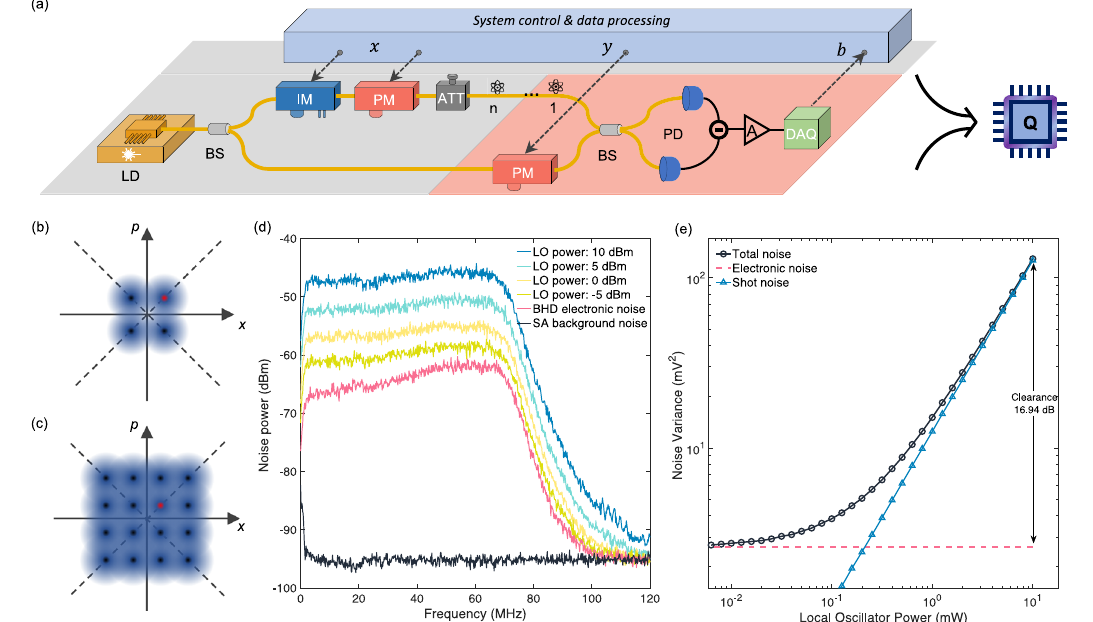
Fig. 1 | Experiment Overview. a Schematic of the experimental setup. The Laser Diode (LD) emits a continuous-wave laser, which is split into two parts by a Beam Splitter(BS). One is for quantum state preparation, and the other is for Local Oscillator (LO) for homodyne detection. In the signal path, an Intensity Modulator (IM) is used for pulse curving and intensity modulation, and a Phase Modulator (PM) is used for phase modulation. The optical signal is then attenuated to single- photon energy level by an attenuator (ATT). The fi nal quantum states after mod- ulation are in QPSK or QAM-16 format. In the LO path, a PM is deployed for basis choosing for the homodyne detection. The signalstates and the LOare mixedon a balanced BS, and the photocurrent of two photodiodes (PD) are subtracted and further ampli fi ed. Finally, a data acquisition (DAQ) device samples the signal and